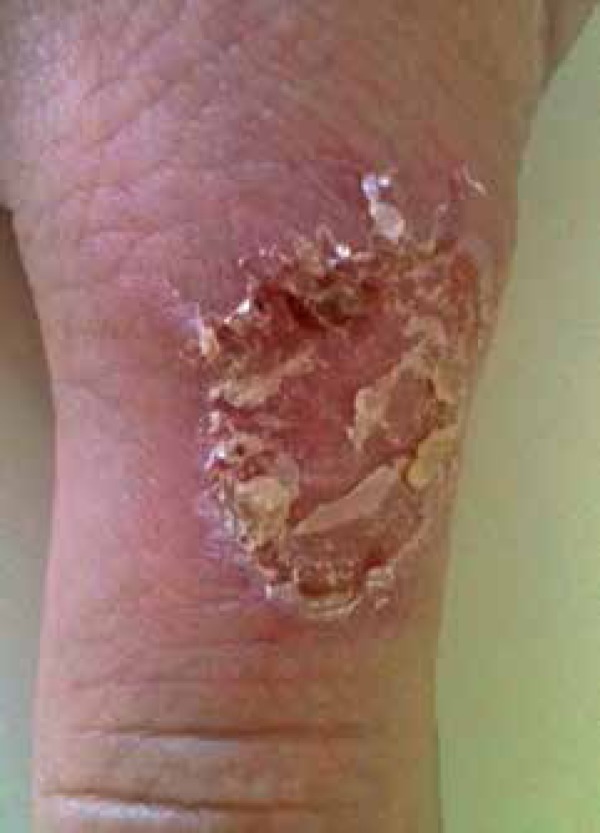
Figure 1 lesion in detail